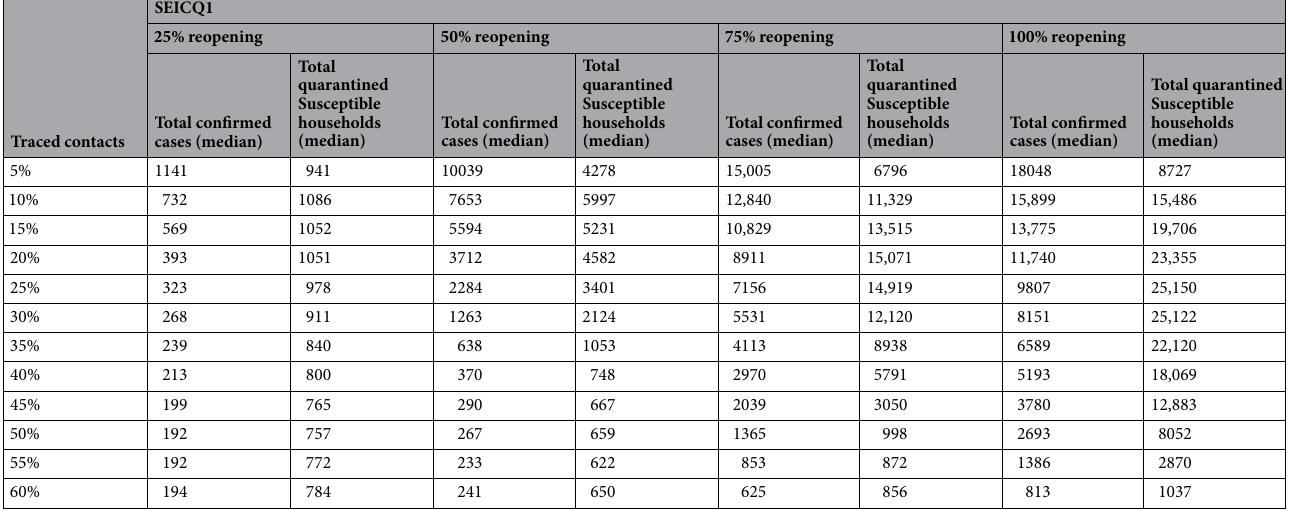
Table 3. Total quarantined susceptible households in eight months after May 4, 2020, in the SEICQ1 epidemic model for the four reopening